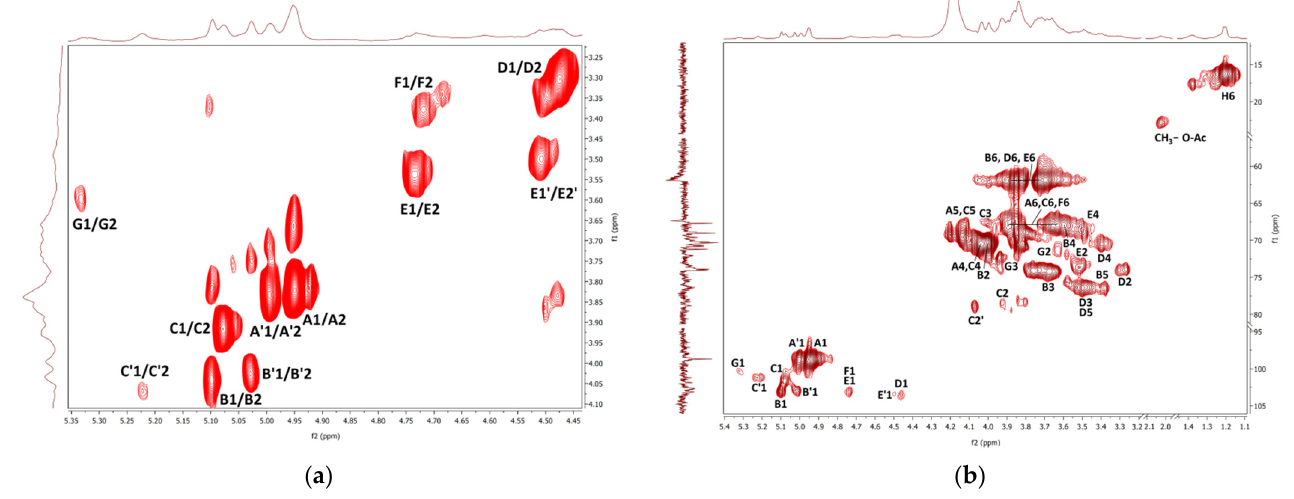
Figure 6. 1 H, 1 H COSY ( a ) and 1 H, 13 C HMQC ( b ) NMR spectra of the fraction F1. Table 6. The assignment of proton and carbon signals (ppm) of the main sugar units for the fractions F1 , F2 , and F3 [30,66,67,73].